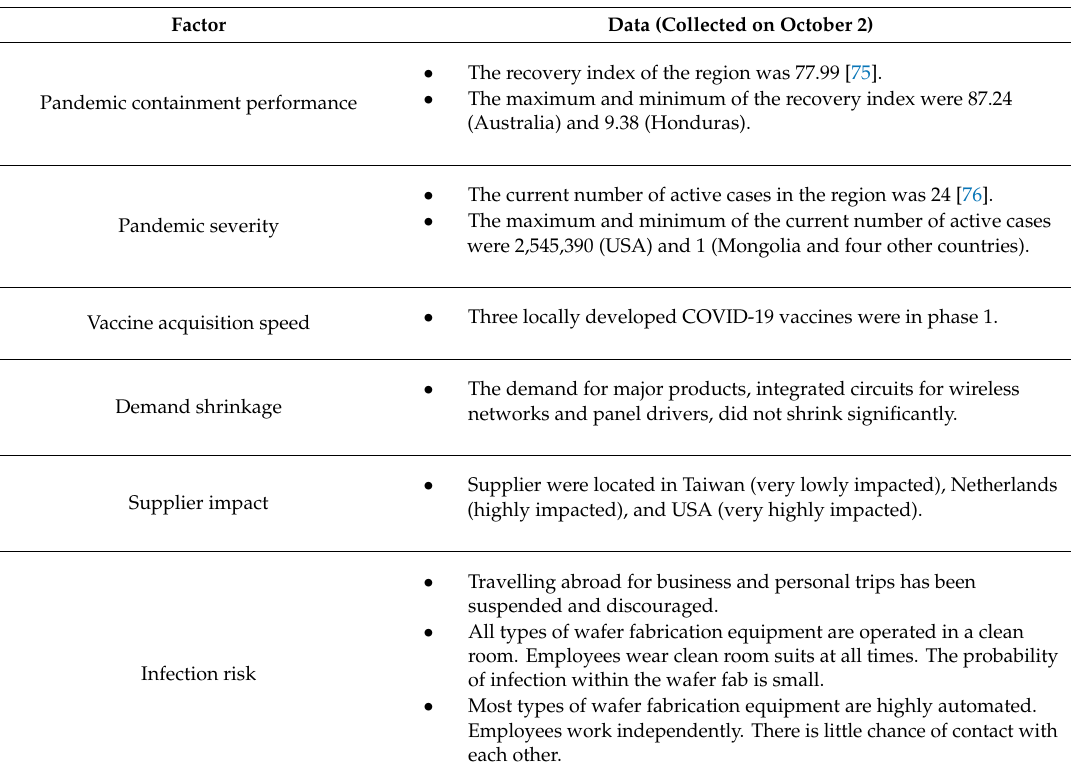
Table 5. Data of the wafer fab in the six aspects.